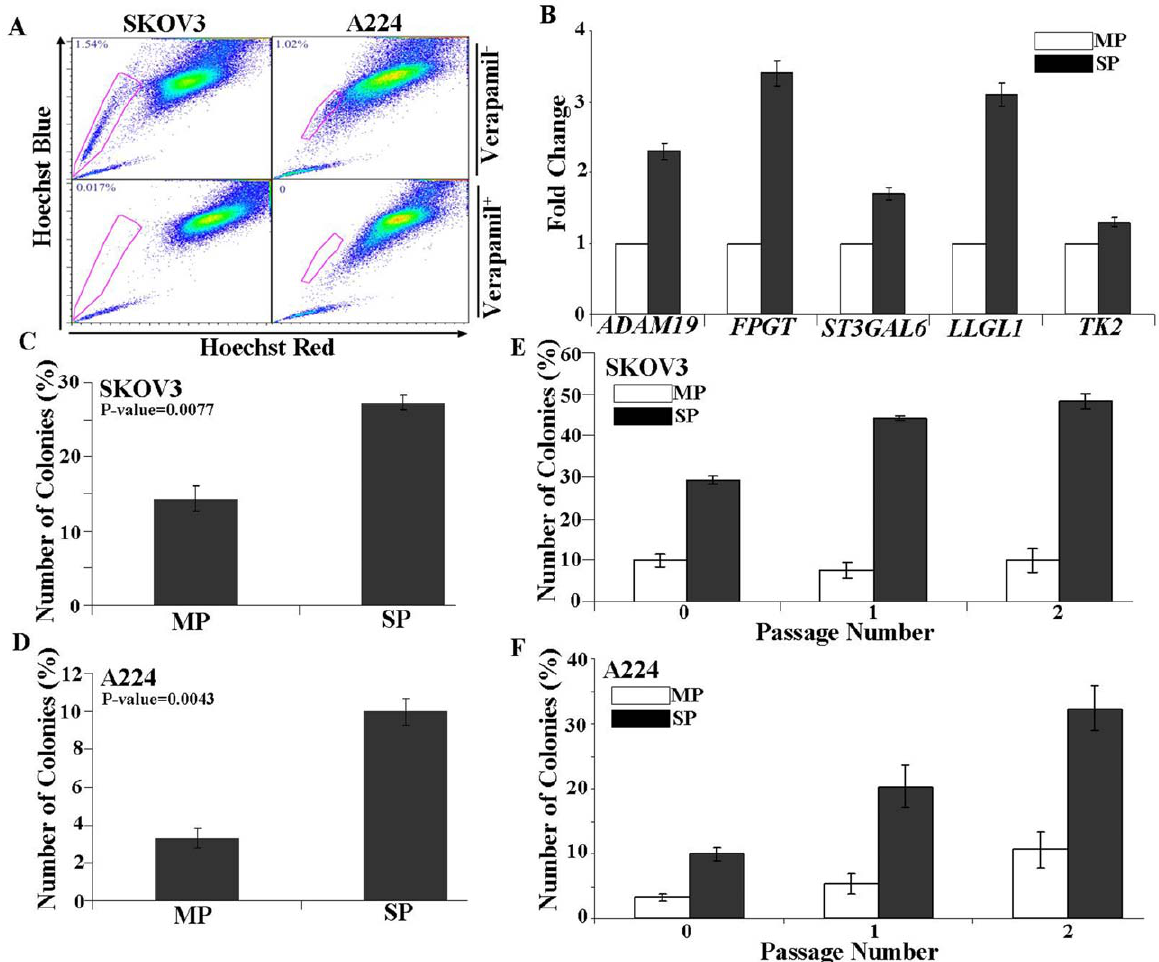
Figure 3. Identification and validation of side population cells from ovarian cancer cell lines. (A) Identification of SP cells in established human ovarian cancer cell lines. SKOV3 and A224 cell lines were labeled with Hoechst 33342 dye and analyzed by flow cytometry. The SP cells, which disappeared in the presence of Verapamil (a multidrug transporter inhibitor), are outlined and shown as the percentage of the total cell population. Similar results were obtained for three independent measurements. (B) Validation of randomly selected genes from the SP gene list on the SP and MP cells isolated from the SKOV3 cell lines. (C, D) Colony forming efficiency assay: Colony forming efficiency of sorted SP and MP cells from SKOV3 and A224 cell lines. For the analysis of colony forming efficiency (CFE), SP and MP cells were sorted and plated in equal numbers in tissue culture six well plates and grown for 14 days. The cells were then fixed with cold methanol and stained with 0.5% crystal violet solution to count the number of colonies by microscopy. The experiments were carried out in triplicates. (E, F) Passage Number: Colony forming efficiency of sorted SP and MP cells from SKOV3 and A224 cell lines were evaluated as a function of passage number. Cells were fixed with cold methanol and stained with 0.5% crystal